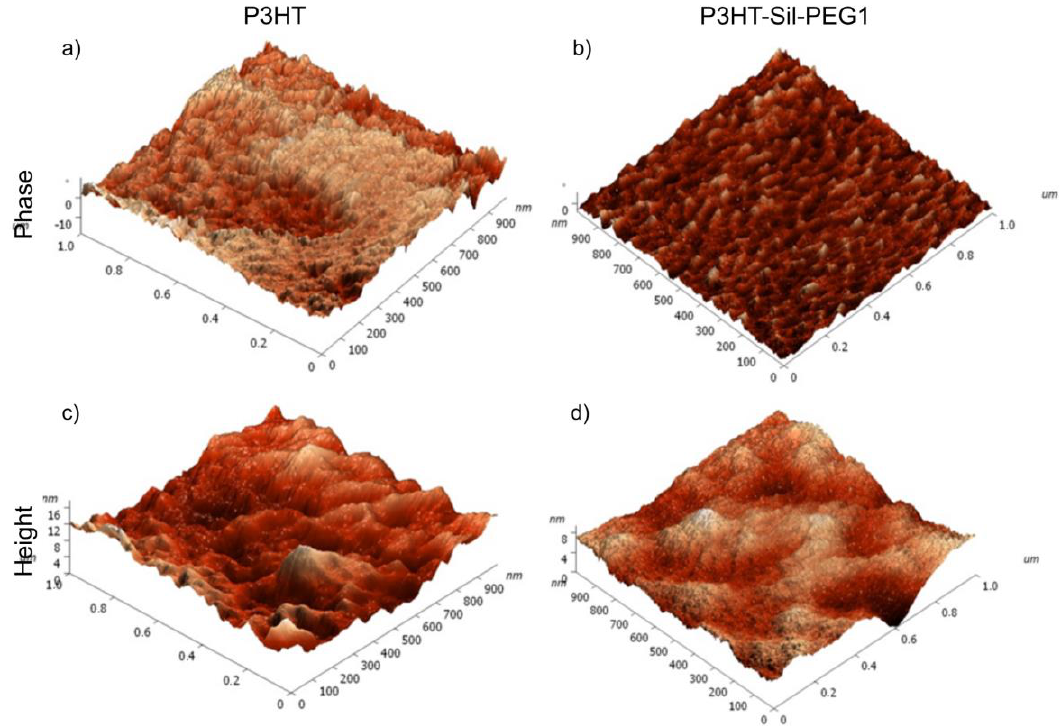
Figure 3. AFM phase: ( a , b ) and height: ( c , d ) images of P3HTvin: ( a , c ) and P3HT-Sil-PEG1: ( b , d ) on ITO electrodes. Images are of 1 µ m × 1 µ m